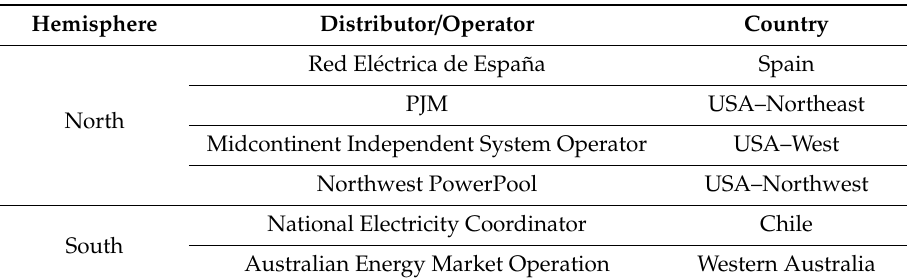
Table 7. Demand load profiles data source [65,80–84].